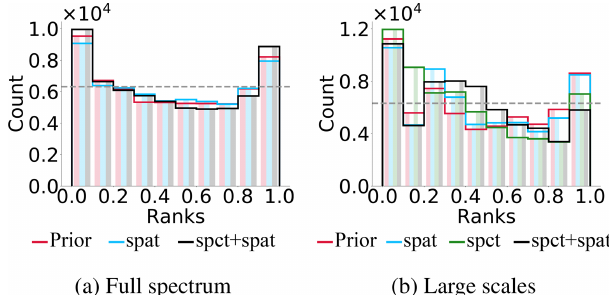
Figure 9. Spatial rank histogram on the Jason domain for the SSH. “Prior” (in red), “spat” (in blue), “spct” (in green) and “spct + spat” (in black) correspond, respectively, to the prior ensemble, spatially updated ensemble, spectrally updated ensemble and the multiscale updated ensemble. (a) Full spectrum; (b) after extraction of the large scales: l ∈ [0 ; l c ], with l c = 34.